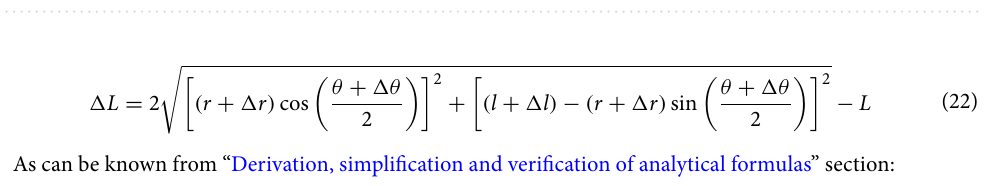
Figure 11. The geometry parameters of the novel metamaterials: ( a ) tetra chiral structure; ( b ) anti-tetra chiral